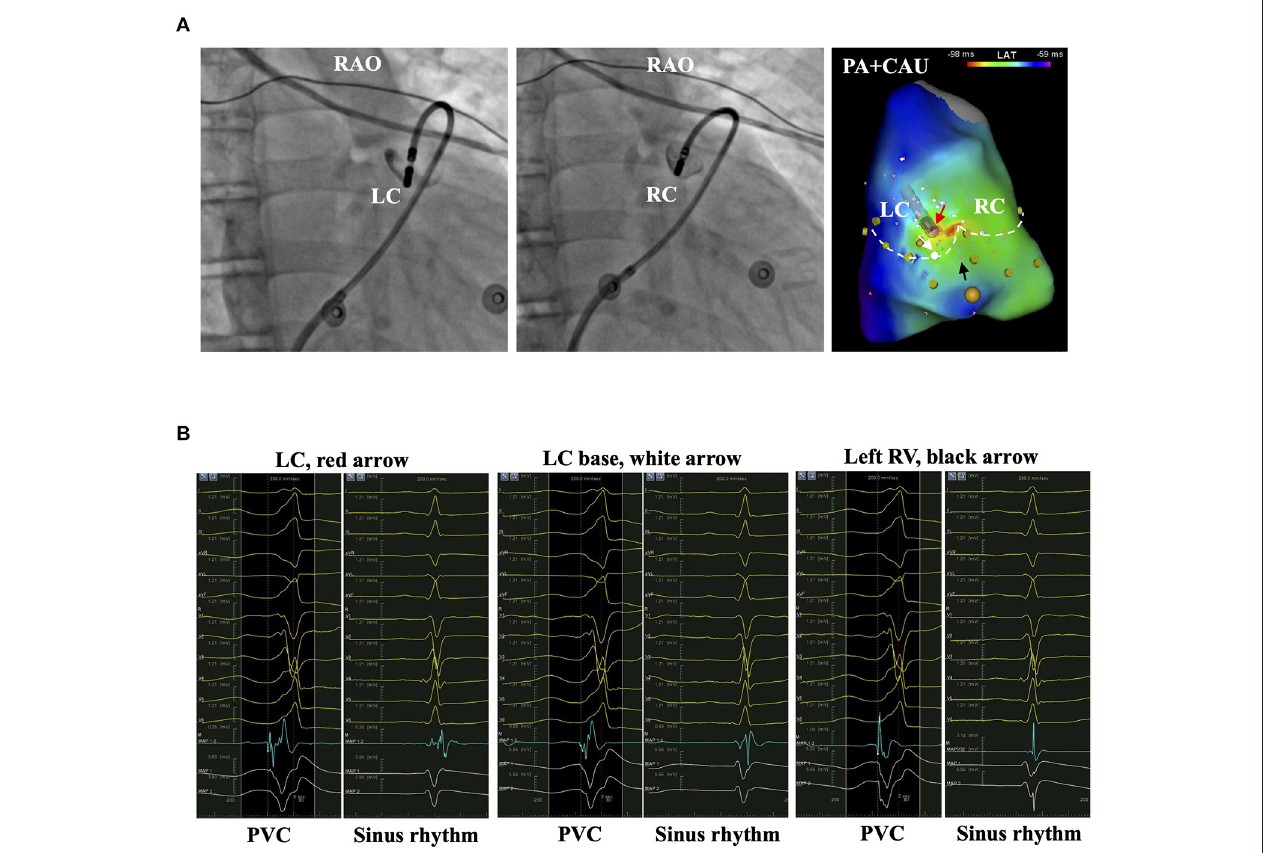
FIGURE 8 | The representative patient with PVC originating from LC. (A) The left and middle panels show the bases of LC and RC by injecting contrast from the irrigation tube of the catheter. The right panel shows the activation mapping. The white dashed line denotes the PVVJ. The red arrow marks the EVA site 5.9mm above PVVJ. White and black arrows mark the less early activation site at the LC base and left RV. (B) The panels show the electrograms in PVC and sinus rhythm recorded at the arrow-denoted sites from left to right. The red dashed line denotes the reference. The yellow dashed line denotes the LAT. EVA, earliest ventricular activating; LAT, local activating time; LC, left cusp; PVC, premature ventricular contraction; PVVJ, pulmonary valve–ventricle junction; RC, right cusp.